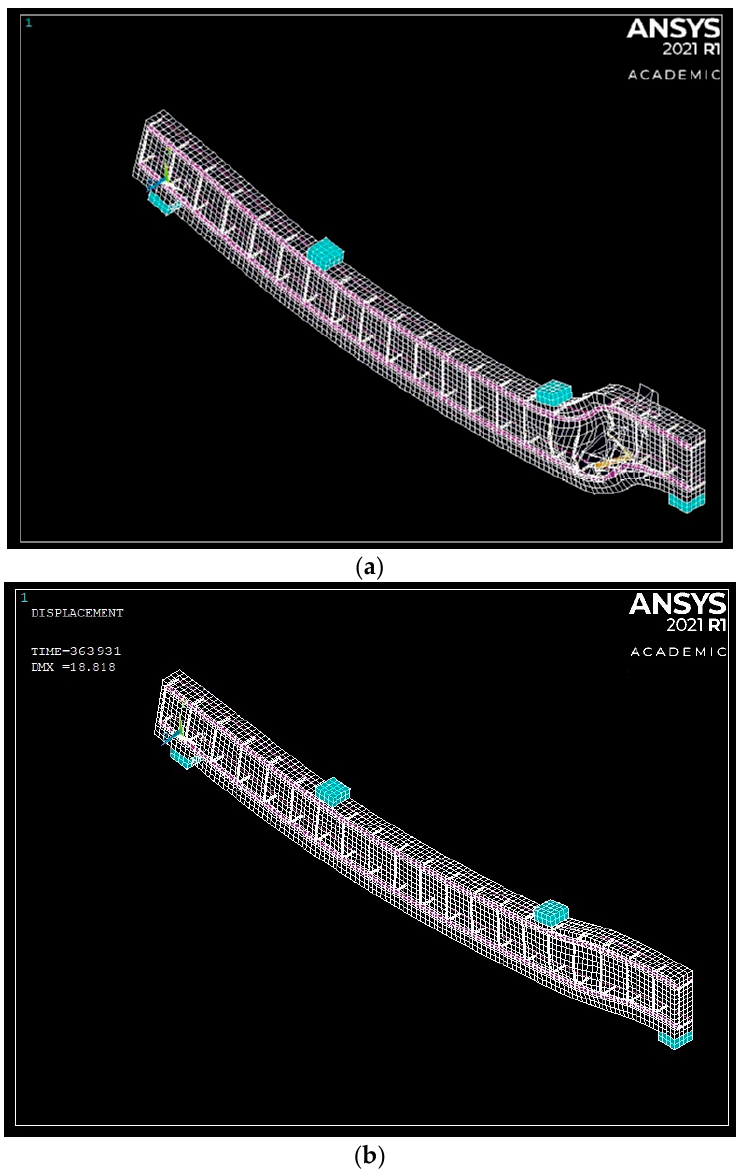
Figure 14. Typical 3D deflection shapes: ( a ) typical shear failure and ( b ) typical flexure failure.